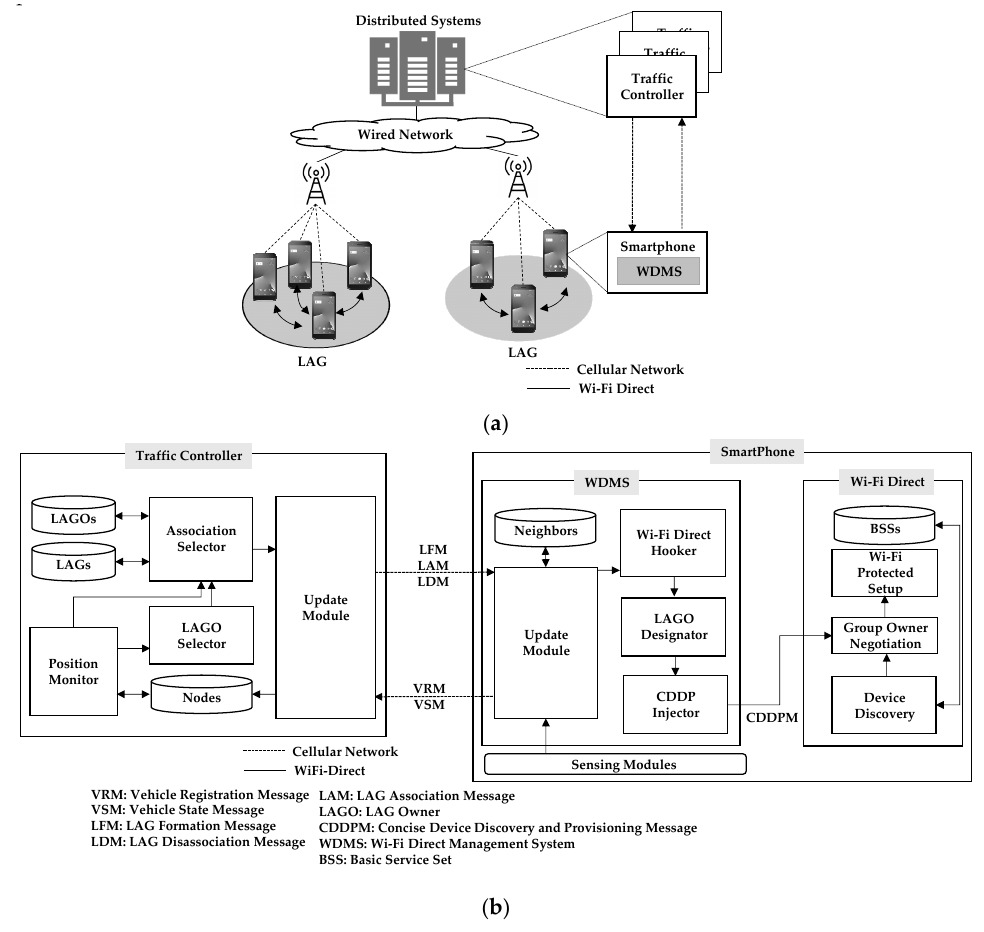
Figure 5. Design and implementation. ( a ) Overall structure of the implemented hybrid V2V communication system (HVCS). ( b ) Details of the traffic controller and the smartphone in the HVCS.